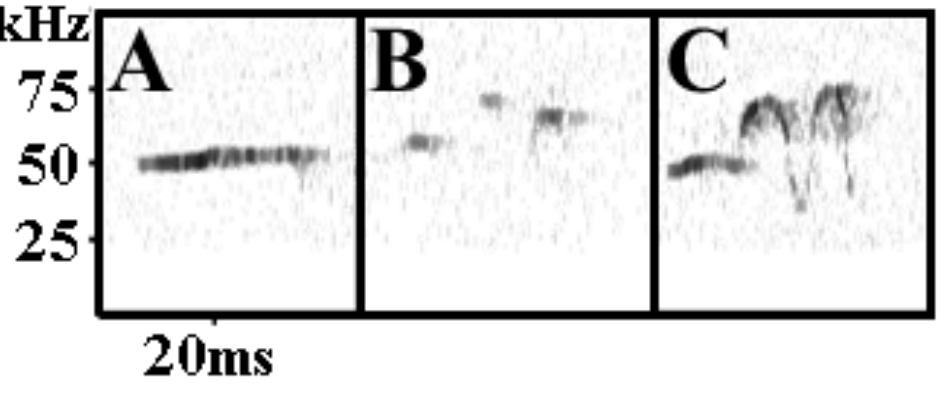
Figure 6 . Example USV sonograms. A) Flat call, B) Non-continuously modulated call, C) Continuously modulated